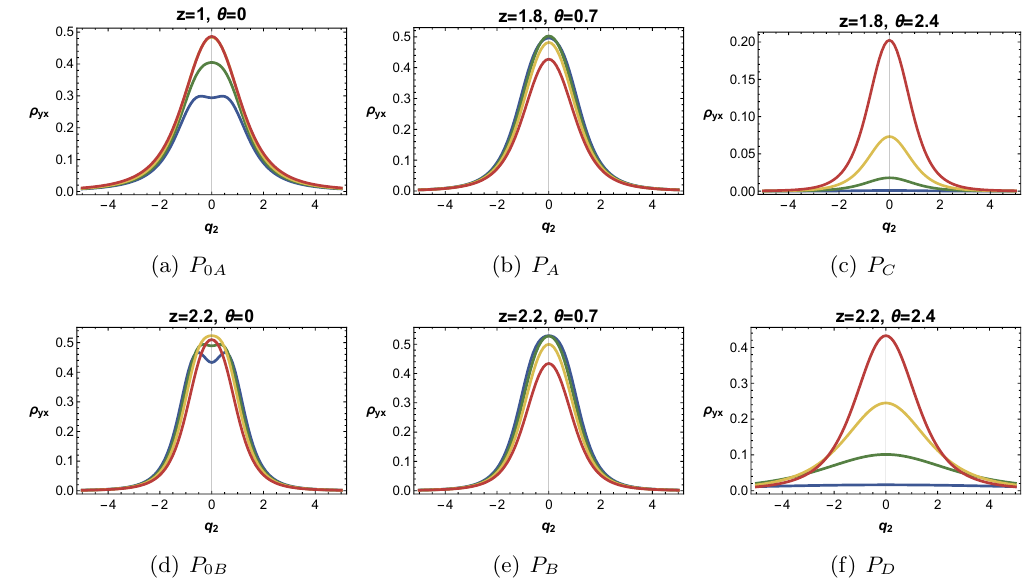
Figure 20 . Temperature evolution for (cid:26) yx ( q 2 ) for di(cid:11)erent ( z; (cid:18) ). Each curves corresponds to T = 0 : 04 ; 0 : 1 ; 0 : 16 ; 0 : 24 for blue, green, yellow, and red respectively. In all (cid:12)gure, q (cid:31) = 5.